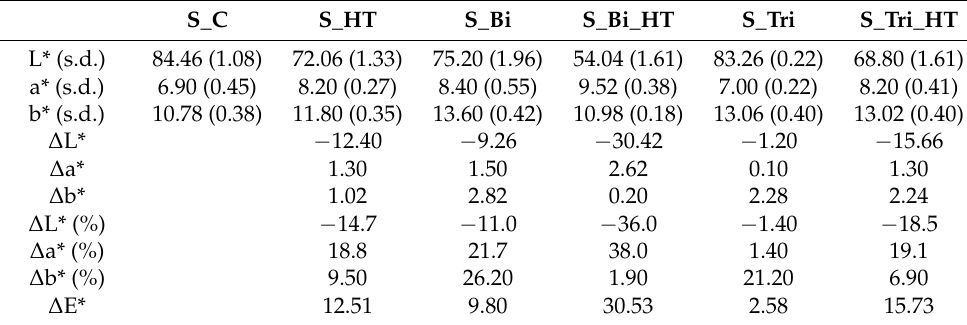
Table 3. Colour determinations of Norway spruce (S) treated with bicine (Bi) and tricine (Tri), respectively. HT = thermal